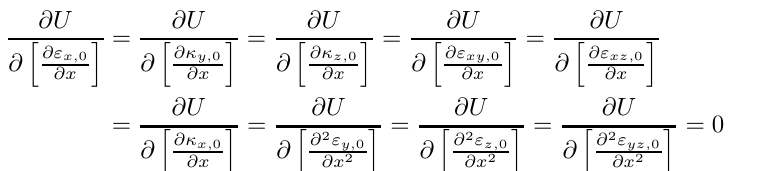
Fig. 1. Schematic of the fundamental element of the in fl atable lattice